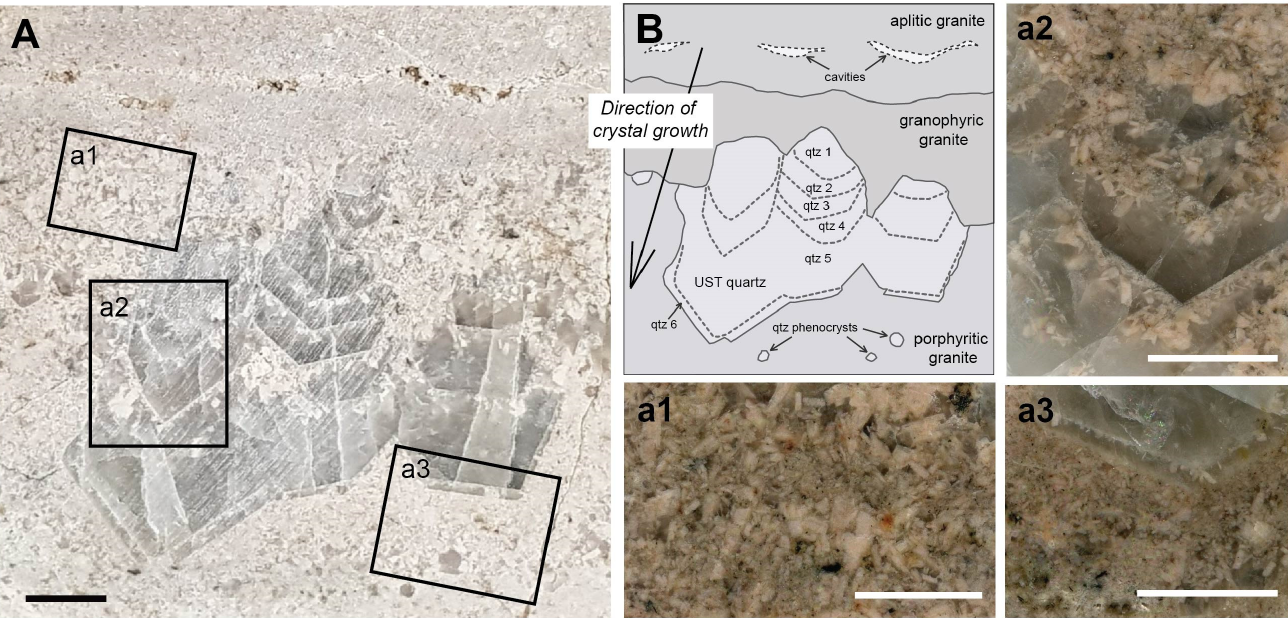
Figure 2. ( A ) Photo and ( B ) sketch of rock slab showing a sequence of the Eonyang UST samples. Scale bars represent 2 cm. The UST sample shows a temporal sequence of igneous and magmatic-hydrothermal textures, including the earliest aplitic granite with sub-horizontal cavities, ( a1 ) granophyric granite showing the co-growth of feldspar-quartz, ( a2 ) UST quartz showing the growth of larger crystals of feldspars and quartz, and ( a3 ) the latest quartz porphyry. The UST quartz develops a clear perpendicular zonation along its c-axis showing the six stages of quartz generations (qtz 1–qtz 6). Feldspar in the UST sample is partly altered to sericite.